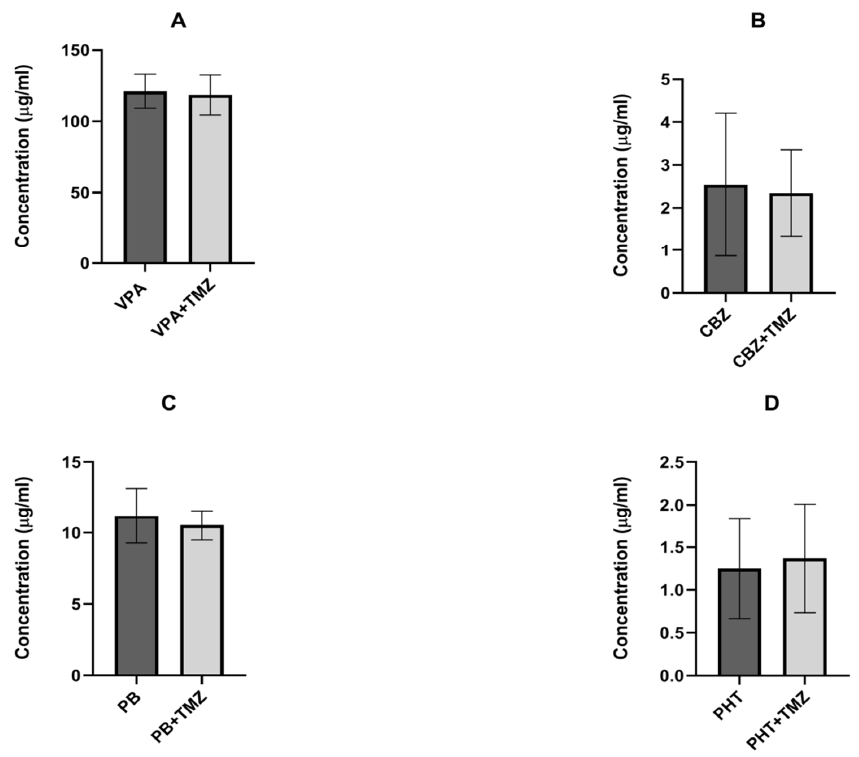
Figure 3. Effect of trimetazidine (TMZ) on the brain levels of ( A ) valproate (VPA), ( B ) carbamazepine (CBZ), ( C ) phenobarbital (PB), and ( D ) phenytoin (PHT). Results are presented as the ± SD (in µg/mL) of at least eight determinations. Statistical analysis was performed using an unpaired Student’s test. TMZ—trimetazidine, VPA—valproate, CBZ—carbamazepine, PB—phenobarbital, and PHT—phenytoin.